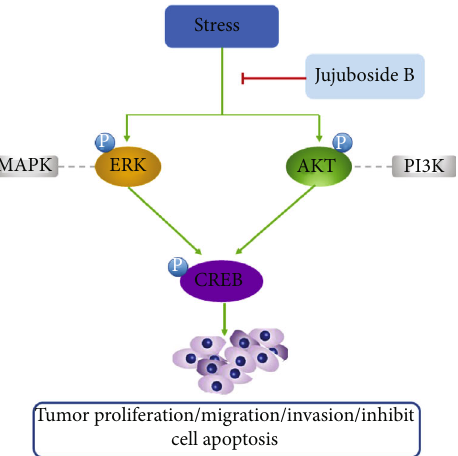
Figure 9: Working model of JUB-induced in fl ammatory